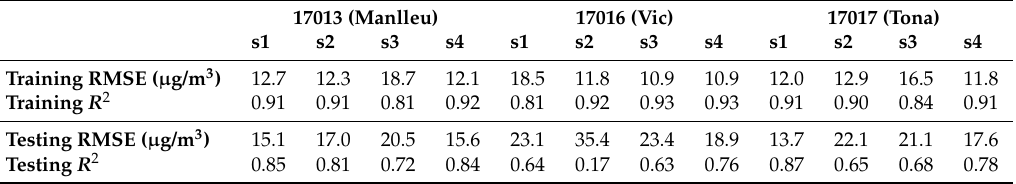
Table 3. Training and testing RMSE, R 2 for nodes 17013, 17016 and 17017.